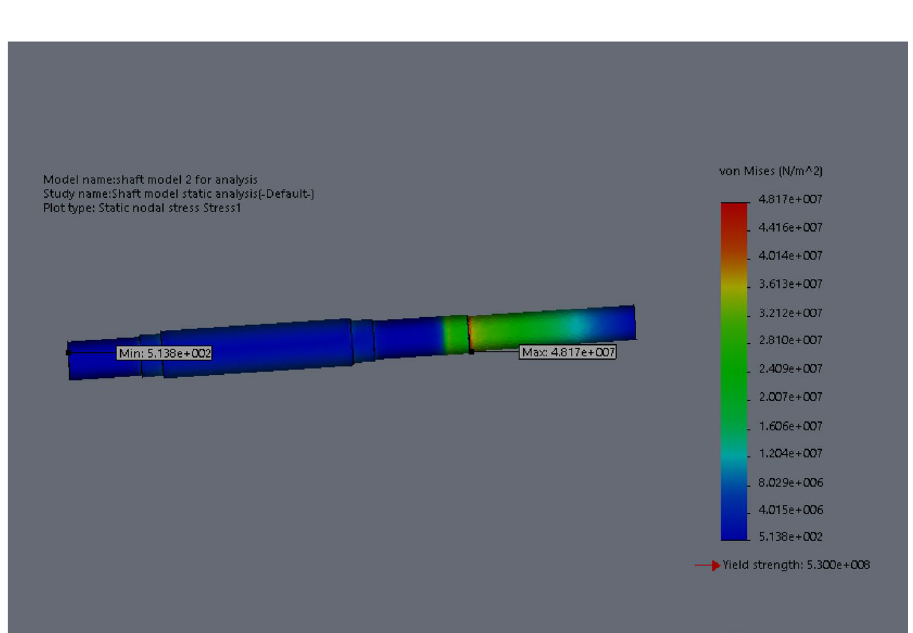
Figure 20. Plots of the stress.